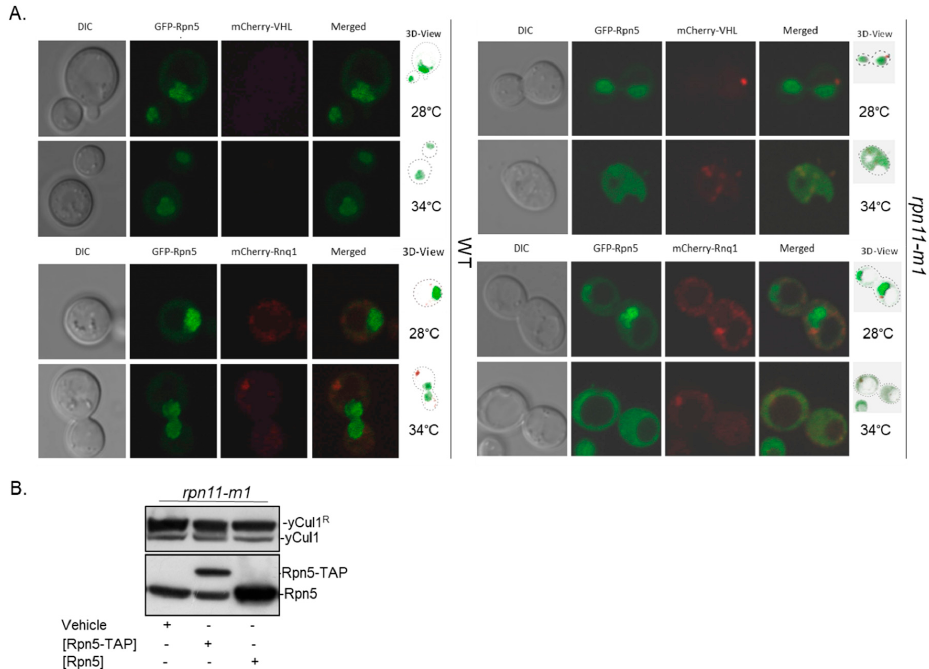
Figure 3. Intracellular distribution of Rpn5 in rpn11-m1 . ( A ) WT (left) and rpn11-m1 mutant cells (right) expressing a genomic copy of Rpn5–GFP and plasmids expressing either mCherry-VHL (top) or mCherry-Rnq1 (bottom). Cells were grown at indicated temperatures for 5 h and images of living cells were taken by ×100 oil immersion objective using a confocal microscope (Zeiss LSM 510). Z stacked images were captured at 0.5 µM intervals and images were processed using Zen Lite software. ( B ) Total cell extracts from rpn11-m1 constitutively expressing Rpn5-TAP under ADH1 promoter or